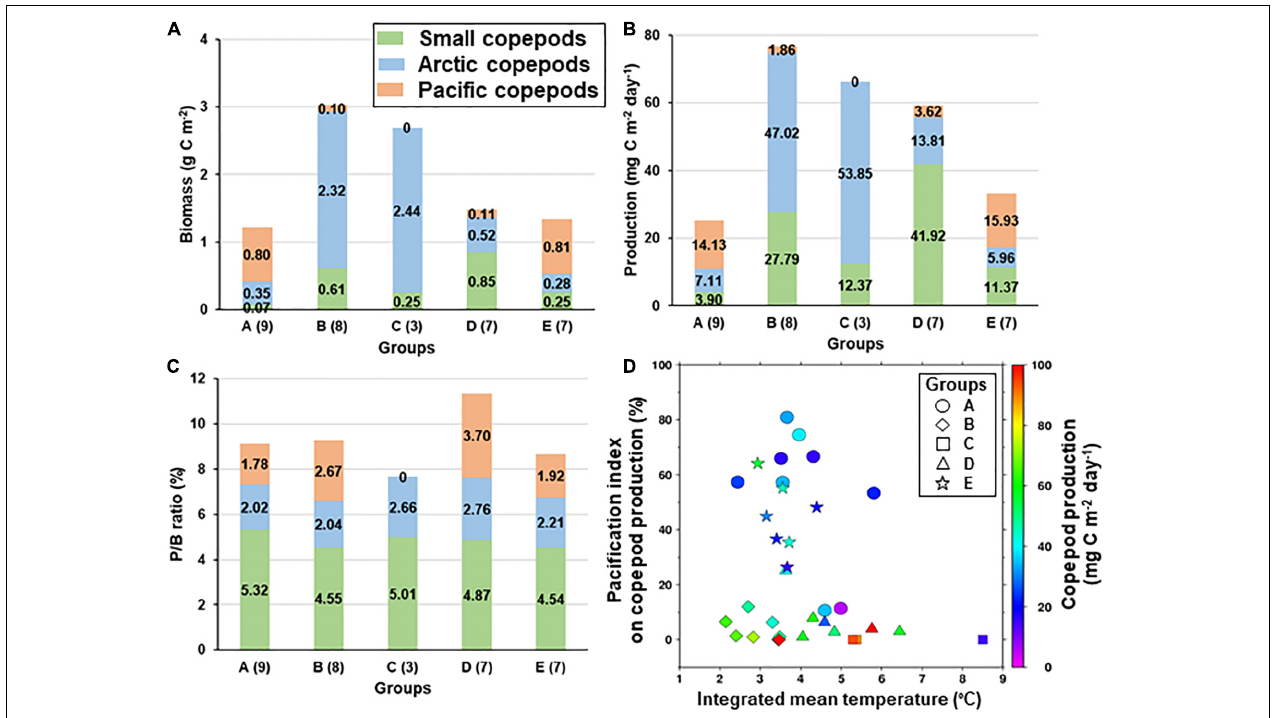
FIGURE 9 | Inter-group comparison of copepod biomass (A) , production (B) , and P/B ratio (C) by group category (cf. Supplementary Table 2 ) in the northern Bering Sea during July 2017 and 2018. The values in the parenthesis are the number of stations in each group (cf. Figure 4A ). Relationship between the pacification index, temperature, and total copepod production in the northern Bering Sea during July 2017 and 2018 (D) . The pacification index in the copepod community was calculated by dividing the Pacific-copepod production by the whole copepod production (see the “Materials and Methods” section for more details). The symbols indicate cluster